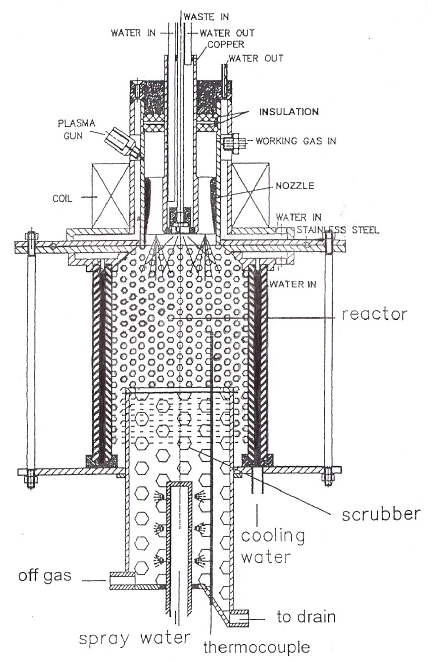
Figure 1: Rotarc plasma device, reactor and scrubber